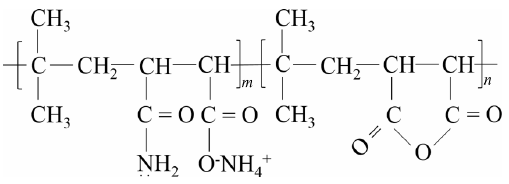
Fig. 1 Molecular structure of PIBM.